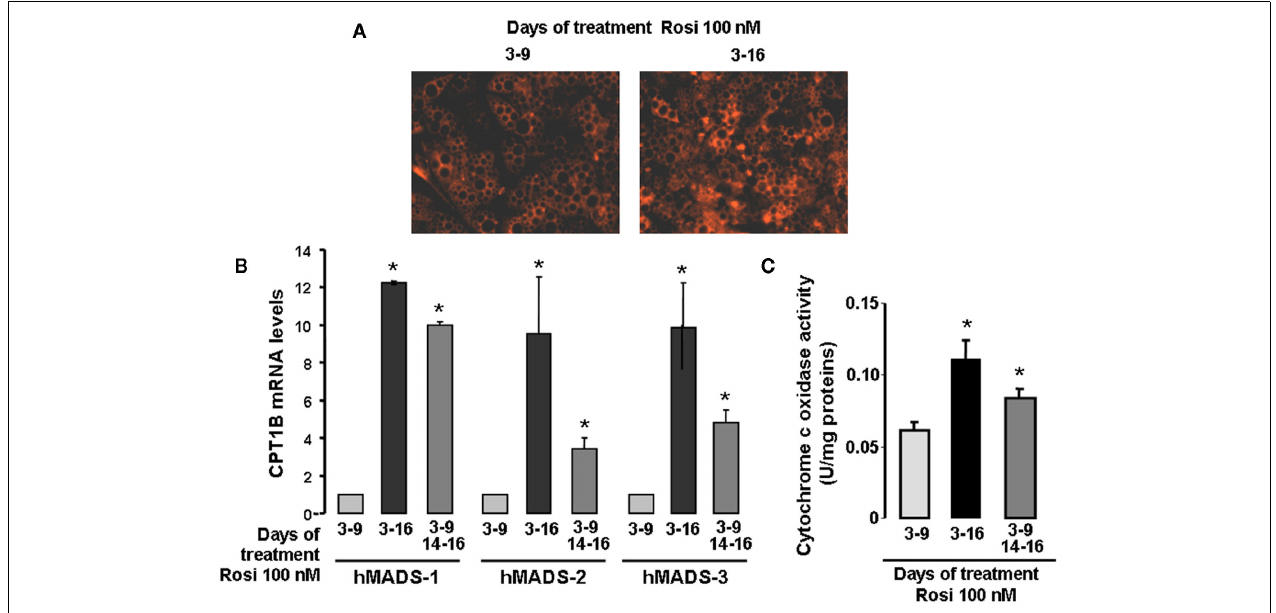
mitotracker dye, (B) CPT1B mRNA levels determined at day 16 by quantitative RT-PCR in hMADS-1, 2, and 3 cells and (C) Cytochrome c oxidase activity determined at day 16. Results are mean ± SEM (B,C) and are representative experiments (A) of three independent experiments performed on different series of cells. * p < 0.05 vs. cells treated between days 3 and